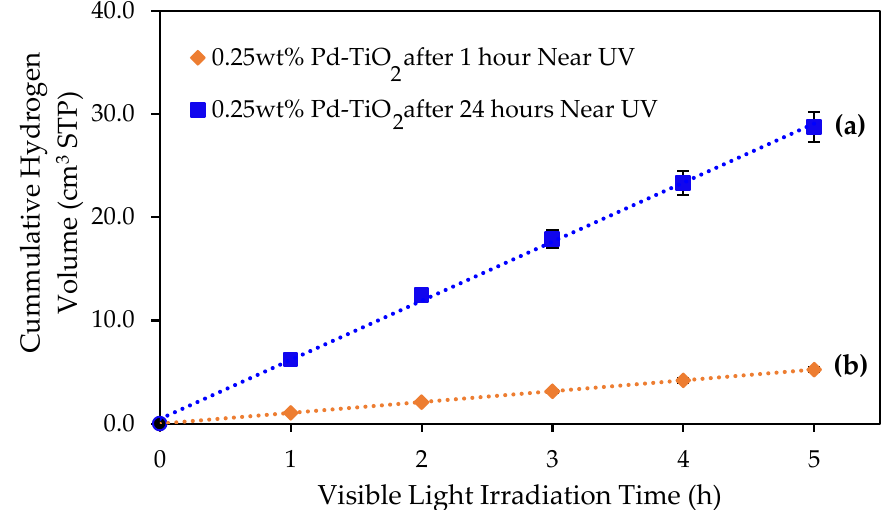
Figure 5. Comparative cumulative hydrogen volume obtained during 5 h of visible light irradiation using the 0.25 wt% Pd-TiO 2 photoreduced photocatalyst as follows: (a) hydrogen volume under visible light after 24 h of near-UV exposure; (b) hydrogen volume under visible light after 1 h of near-UV exposure. Photocatalyst conditions: 0.15 g L − 1 photocatalyst concentration; 2.0 v / v % ethanol; and initial pH = 4 ± 0.05. Notes: There were at least three repeats per experiment.